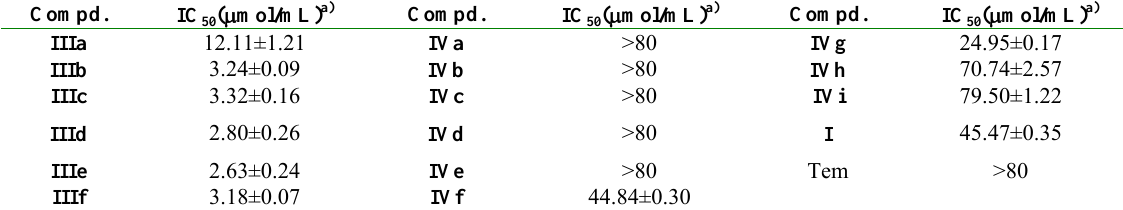
Table 2. Growth inhibition activity of some temozolomide analogues on HL-60 cell.